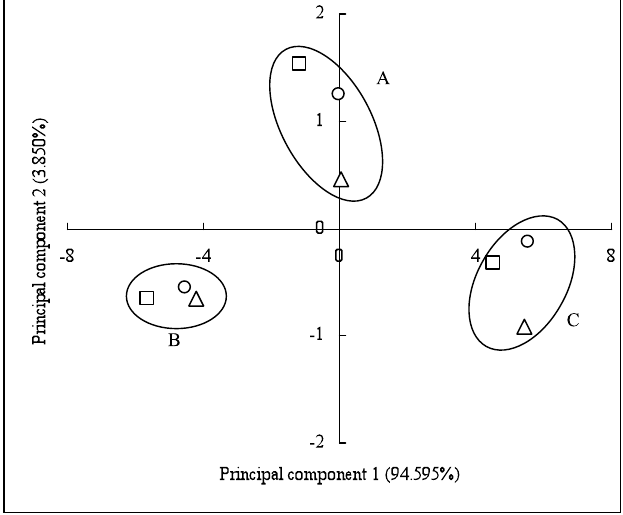
Fig. 3: Loadings for principal component analysis (PCA) derived from the 18 free amino acid contents of tea leaves from the different plantations. A: Yu. B: Qishan. C: Guiyan. ∆ : Dahongpao. □ : Shui- xiang. ○ :